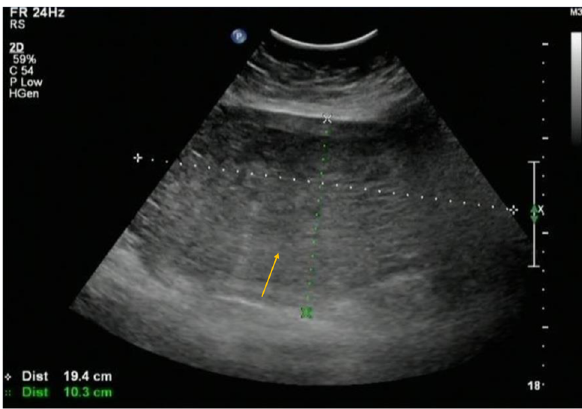
Figure 1: Ultrasound images showing a huge molar mass and faveolate subechoic area ( arrow ) in the uterine cavity.